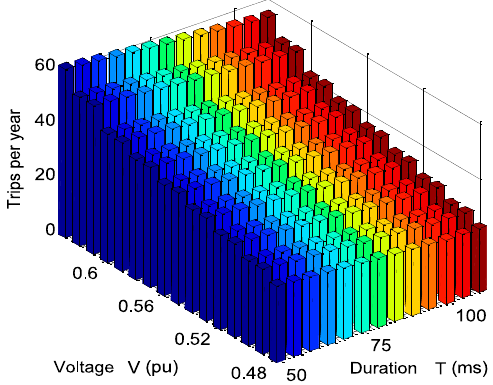
Figure 12. Number of expected equipment malfunction for PC at specified bus.